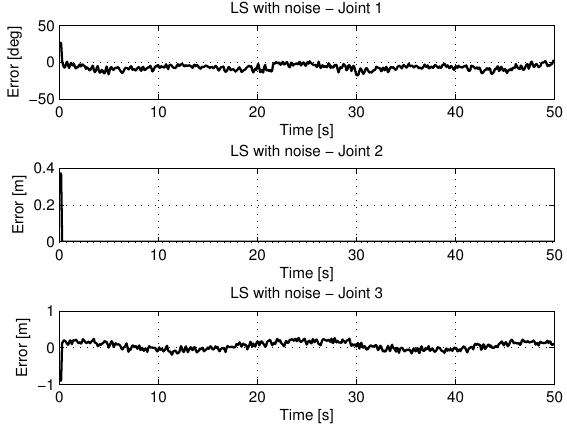
Figure 23. Error of Trajectories identifications with LS with